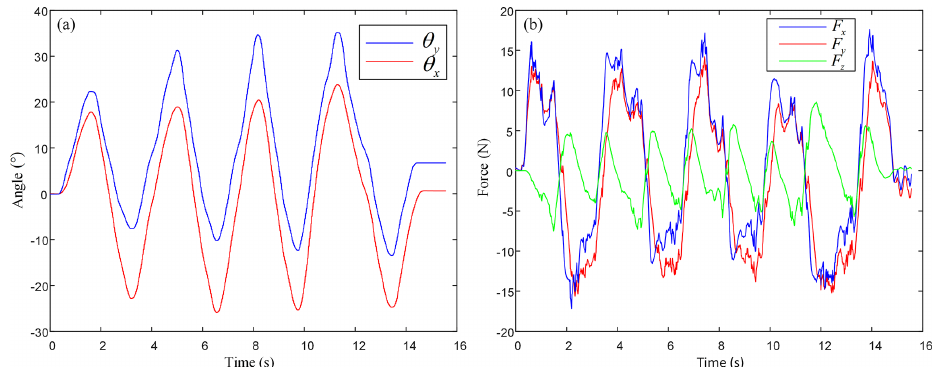
Figure 14. Control process of the haptic interface approaching sinusoidal motion. (a) Operating conditions of the haptic interface; (b) cal- culation results.